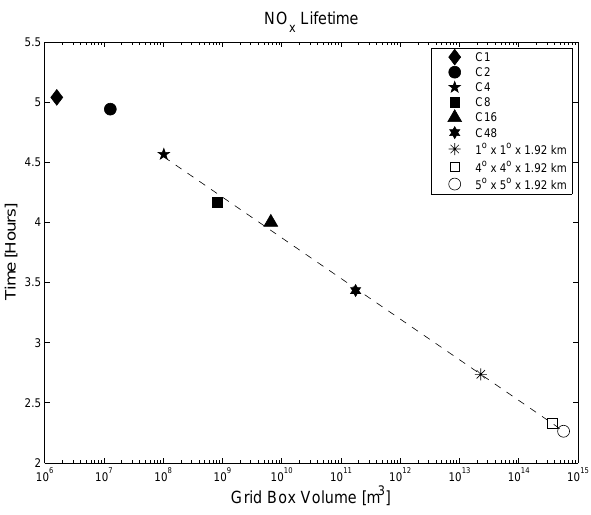
Fig. 7. Domain mean OPE at 12:30 (local) on day 2 for different resolutions. Dashed line represents best fit to the model results C4, C8, C16 and C48. Extrapolation as in Fig. 5. For comparison, the clean model run produces a domain mean OPE of 21.3 at the same